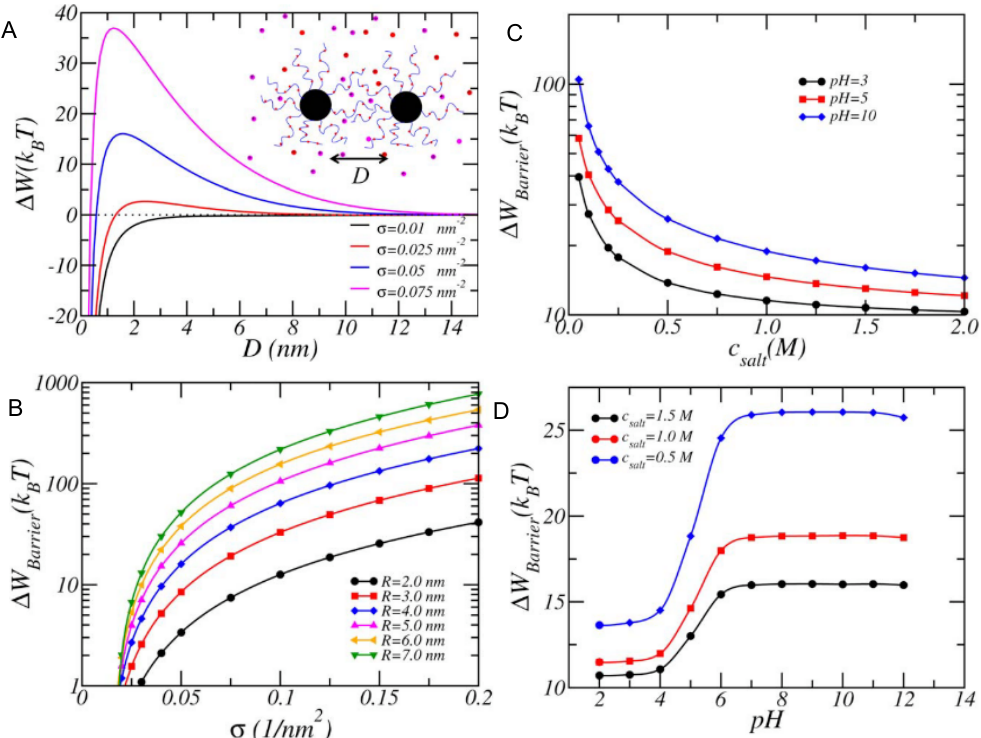
Figure 3. Stability of NPs coated with pAA-a-AMPS polyelectrolytes with N = 50 monomers (ratio AA:AMPS = 1:1). The dissociation constants are K ion (NaCl) = 0.6 M − 1 (ion-pairing), K dis (Na-AMPS and Na-AA) = 8.07 M (ion condensation), and pK a = 5.0 (deprotonation). NP concentration = 10 nM ( A ) Free energy versus separation between NPs with different pAA-a-AMPS surface coverages, as indicated in the legend. NP radius is R = 4 nm. Brine-like conditions: pH = 10 and salt concentration of NaCl = 1.5 M. ( B ) Free energy barrier height or maximum of free energy as a function of surface coverage for different NP core radii. Other conditions as in panel A. ( C ) Barrier height versus salt concentration for various pH values. Conditions: NP radius R = 4 nm, polymer surface coverage σ = 0.05 nm − 2 . ( D ) Barrier height versus pH for various salt concentrations. Conditions as in panel C. (Reprinted with permission from the authors of [93]. Copyright 2014 Wiley Periodicals,